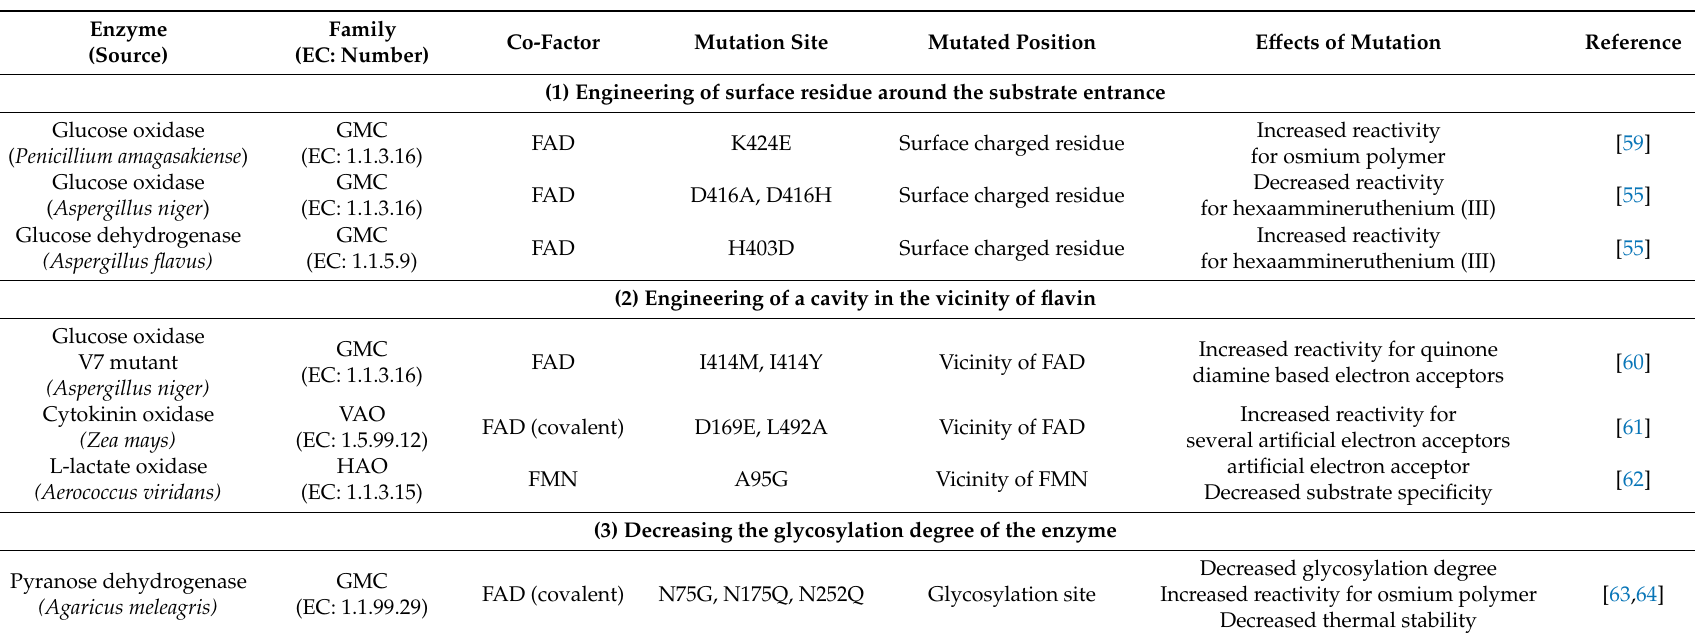
Table 2. Engineering approaches to alter the preferences of flavin-dependent oxidases and dehydrogenases for artificial electron